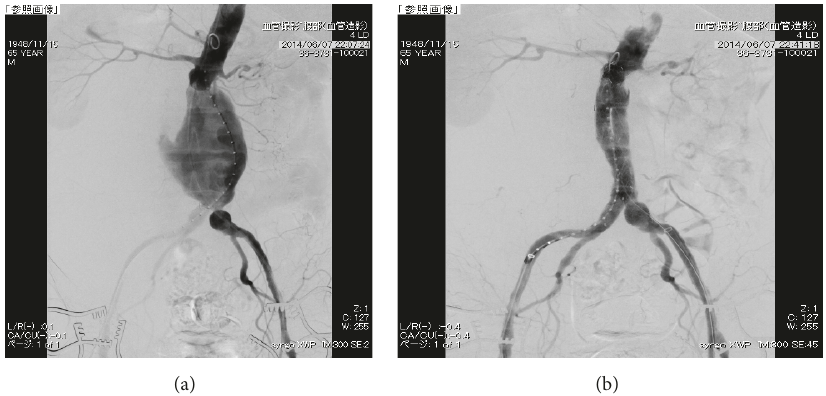
Figure 2: Angiogram before (a) and after (b) endovascular aneurysm repair.